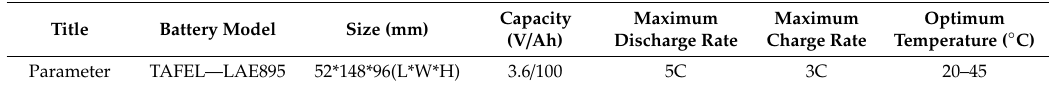
Table 1. TAFEL-LAE895 battery